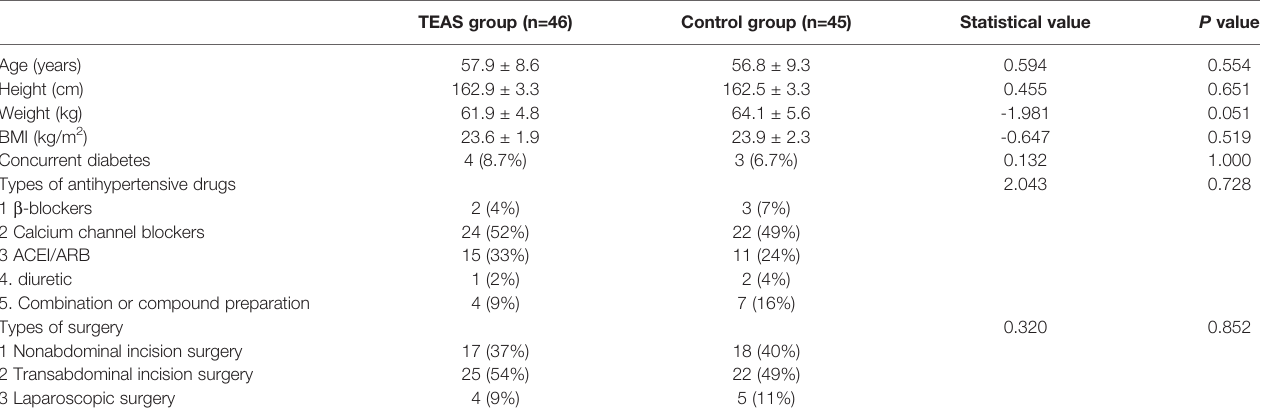
TABLE 1 | General information for both